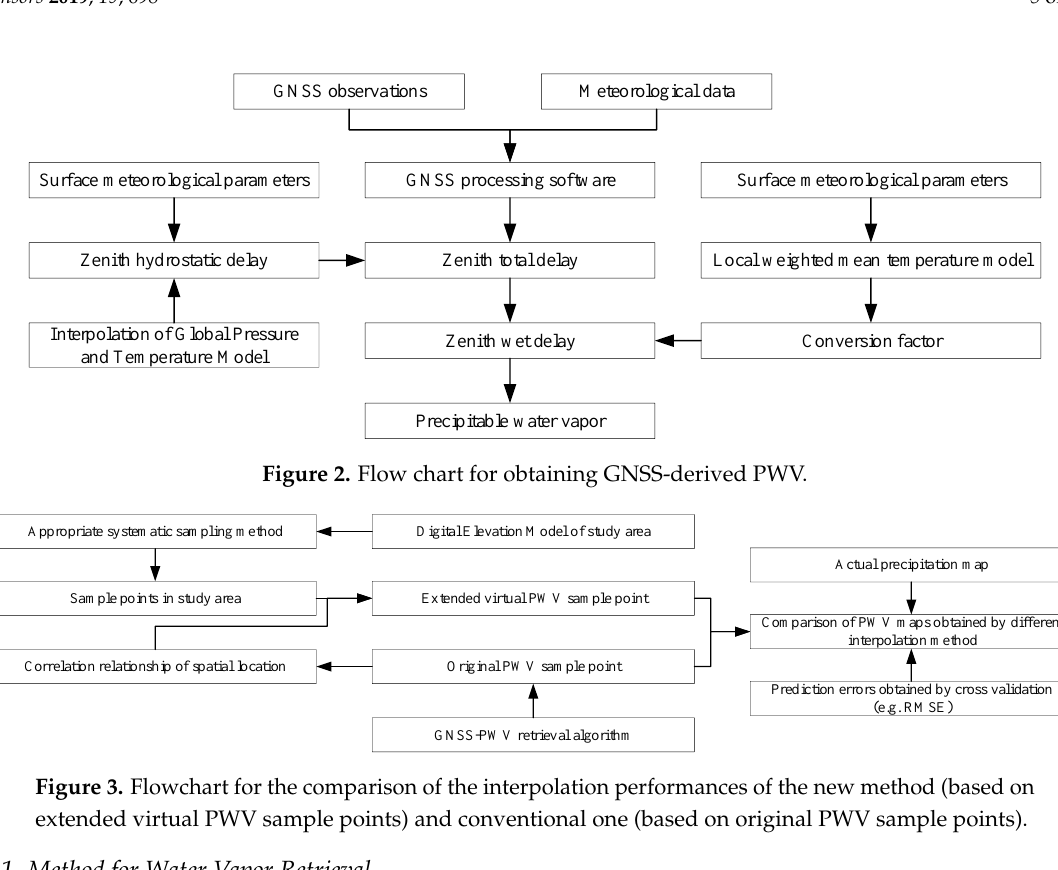
Figure 3. Flowchart for the comparison of the interpolation performances of the new method (based on extended virtual PWV sample points) and conventional one (based on original PWV sample points).